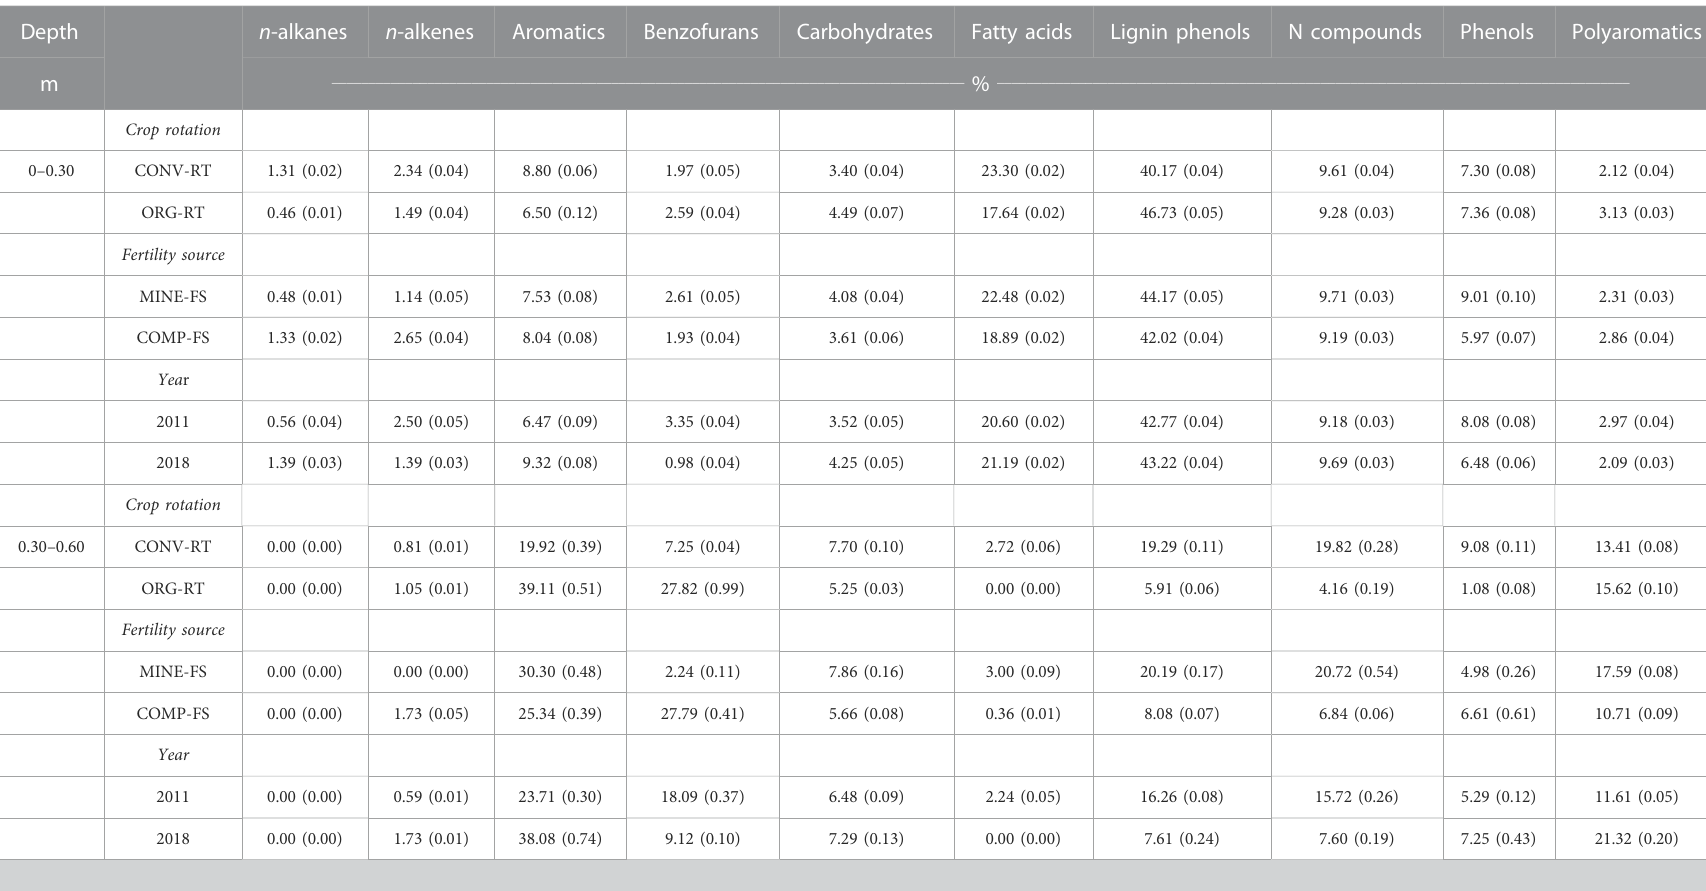
TABLE 6 Relative abundance of groups of pyrolysed product compounds released after Py-GC-MS-TMAH analytical procedures as a result of different crop rotation (conventional-CONV-RT or organic-ORG-RT), fertility sources (mineral-MINE-FS or compost-COMP-FS) and years of sampling (YR) (2011 and